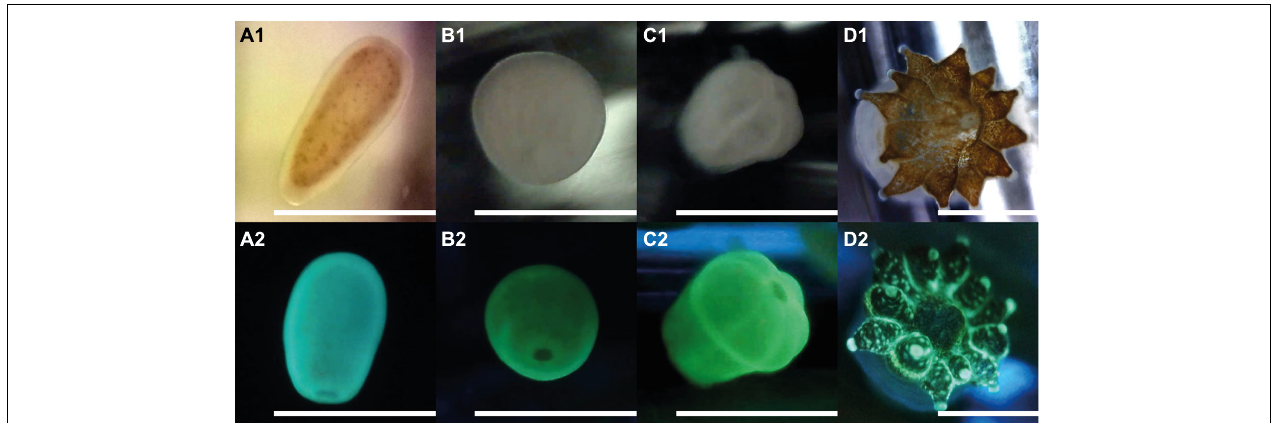
FIGURE 4 | Early life stages of Leptastrea purpurea recruits in response to cycloprodigiosin (I) and alternating dark-light phases of 12 h repeating intervals (starting with complete darkness). Numbers behind alphabetic characters indicate what light setting has been used: (1) was taken using a white LED light while (2) used a blue LED light (wavelength: 460–480 nm) to illuminate the larva/polyp and a yellow filter was applied to capture only the red and green fluorescence emitted from the specimen. (A1,2) planula larvae; (B1,2) 12 h attached recruit; (C1,2) 48 h attached and metamorphosed primary polyp; (D1,2) 1 month old, fully developed coral polyp of Leptastrea purpurea . Scale bar: 1.0